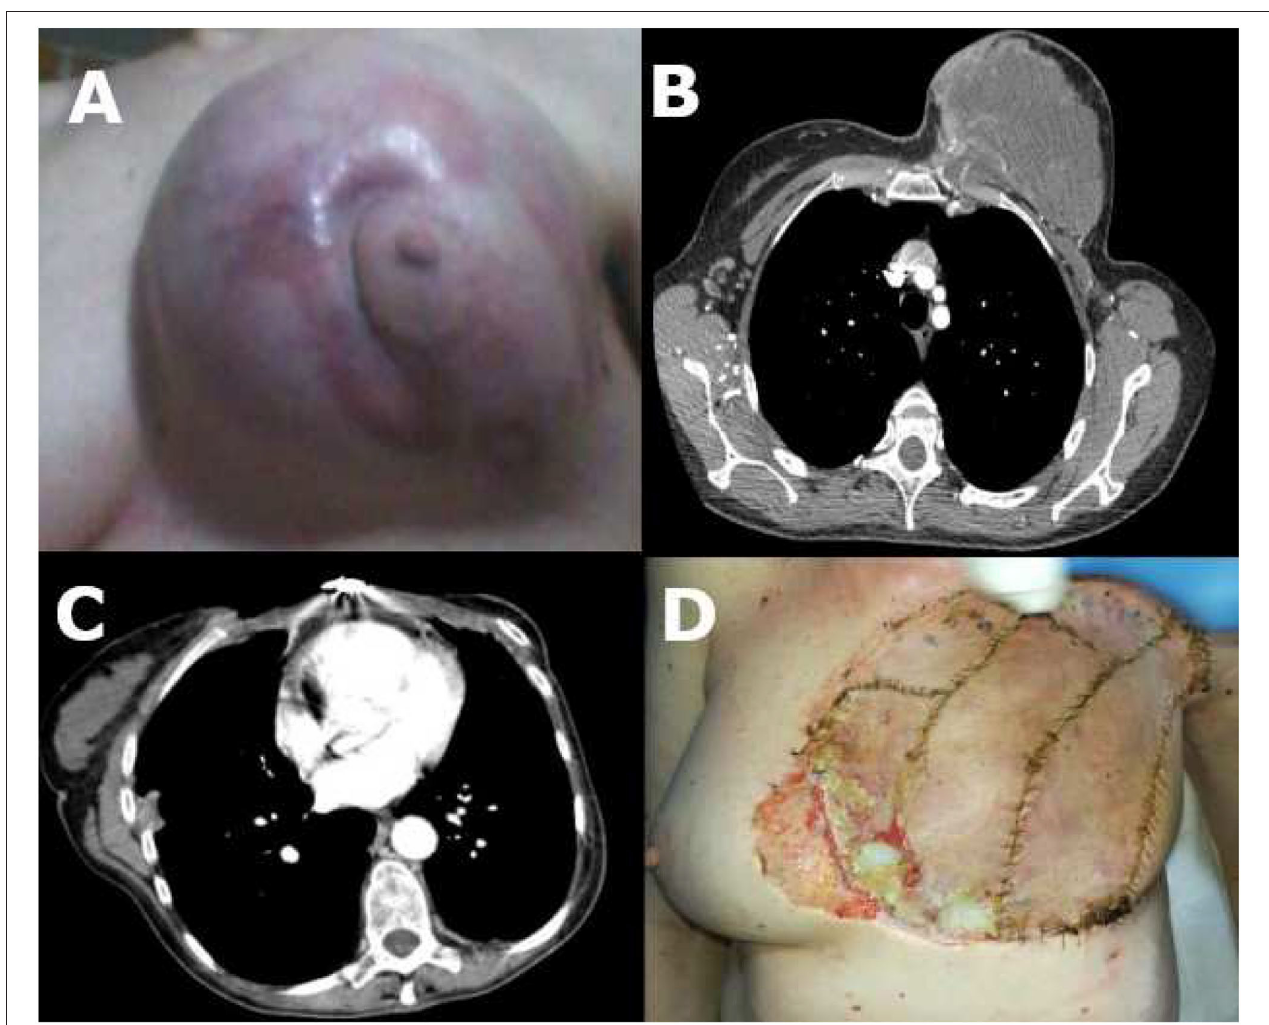
FIGURE 1 | (A) Chest wall sarcoma before surgery; (B) CT scan before surgery; (C) CT scan after surgery; (D) Chest wall sarcoma after surgery with small ulceration (low-right quadrant).